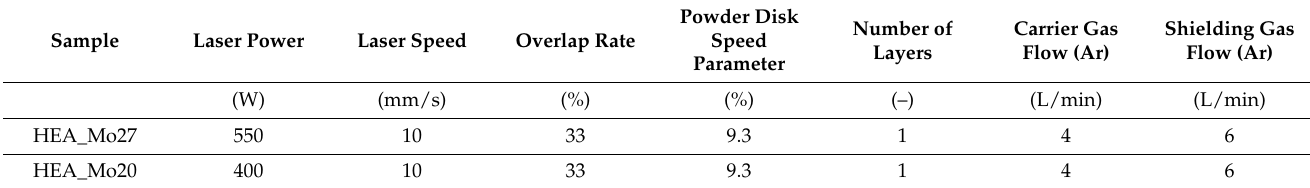
Table 4. Laser Cladding (LC) process parameters employed to deposit the high entropy alloys